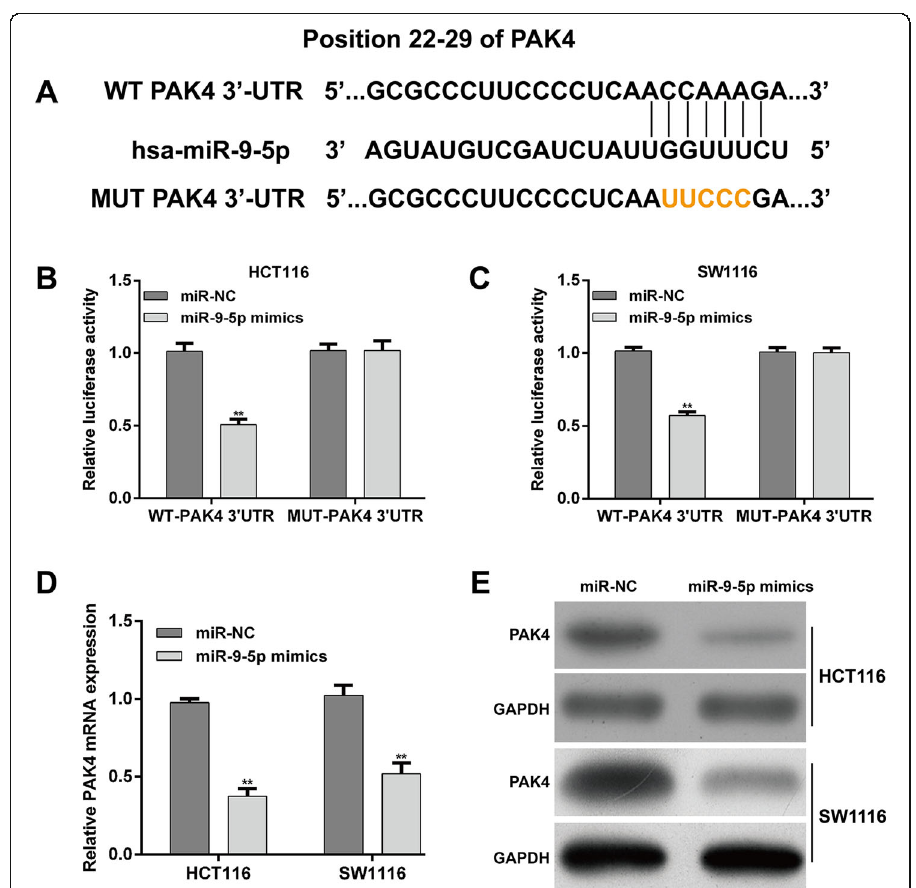
Fig. 3 PAK4 was a target gene of miR-9-5p in CRC cells. a The potential binding sites of miR-9-5p and PAK4 mRNA, as well as the sequences in potential binding sites of mutant-type plasmid. b and c Dual luciferase reporter assays were performed in HCT116 and SW1116 cells with vectors including the putative miR-9-5p target sites in the 3 ′ -UTR of PAK4 mRNA (wild-type) and mutant. Data were normalized against Renilla or firefly luciferase activity. d Quantitative real-time PCR was used to determine the mRNA levels of PAK4 in HCT116 and SW1116 cells transfected with miR-9-5p mimics or miR-NC. e Western blot analysis was used to determine the protein levels of PAK4 in HCT116 and SW1116 cells transfected with miR-9-5p mimics or miR-NC. All data are expressed as the means ± SD. ** p < 0.01, compared with the miR-NC group